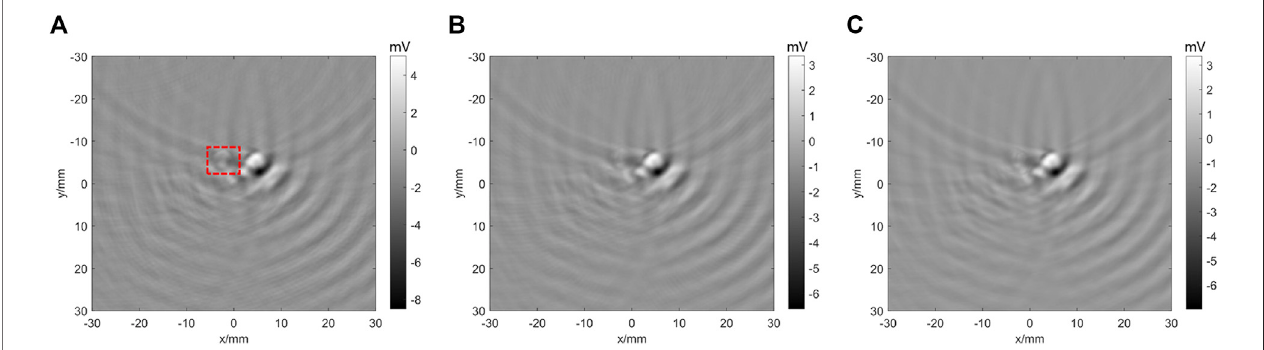
FIGURE10| TTDimages(0 µstimedelay)withdifferentsignalaverages. (A) TTDimagewith10timessignalaverages;theredlineframeistheimagingareaofblack ink. (B) TTD image with 50 times signal averages. (C) TTD image with 200 times signal averages.